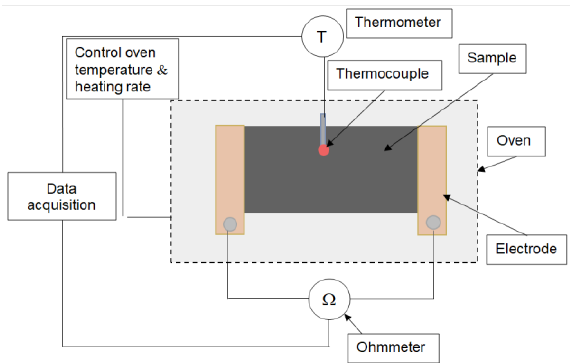
Figure 1. Schematic setup for -T measurements.